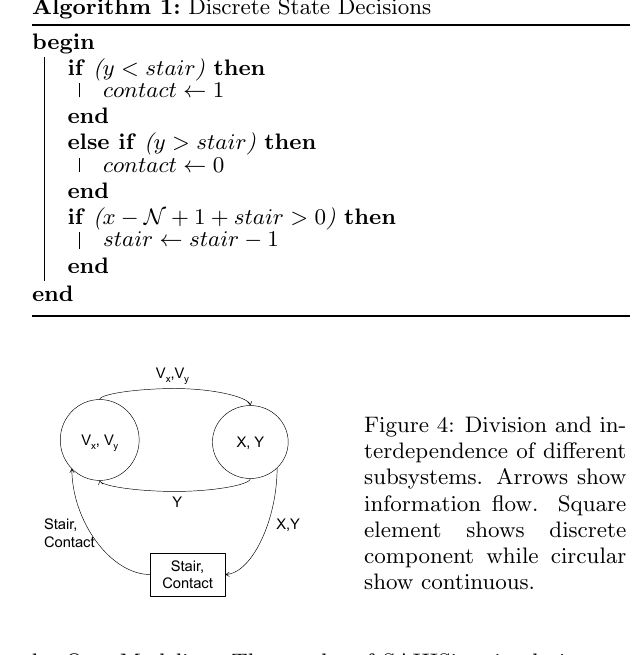
Algorithm 1: Discrete State Decisions